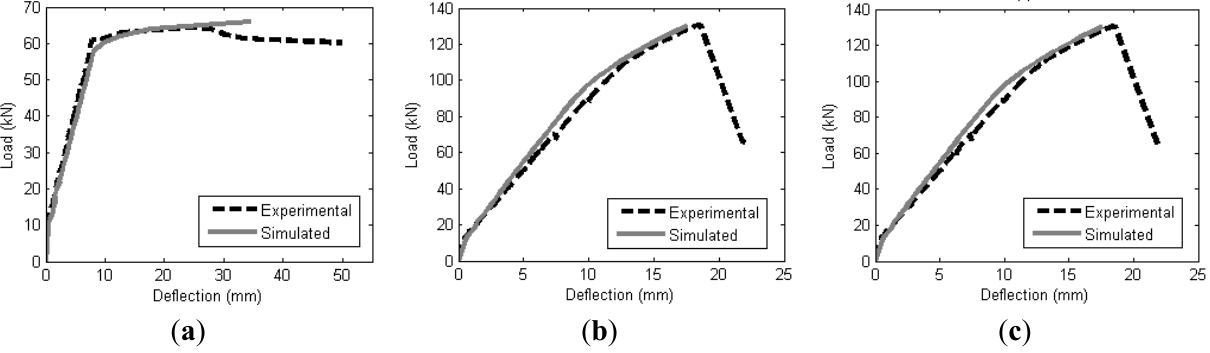
Figure 11. Comparison of experimental and simulated load-deflection of beams CB, A1 and